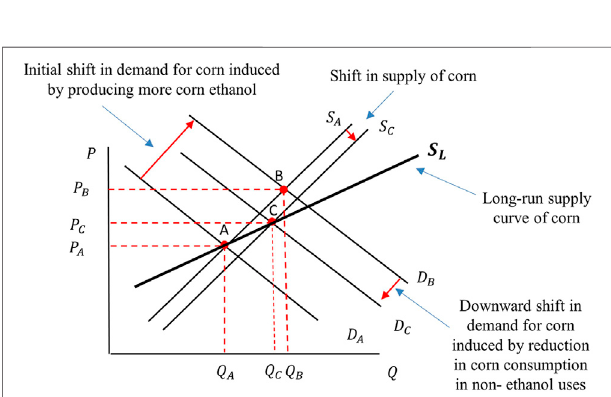
FIGURE 5 | Short-run and long-run changes in corn market. This fi gure was designed to explain difference between the short- and long-run supply elasticities.Thedemandandsupplycurvesandtheirshiftsareallhypothetical. Box 1 shows numerical estimates.